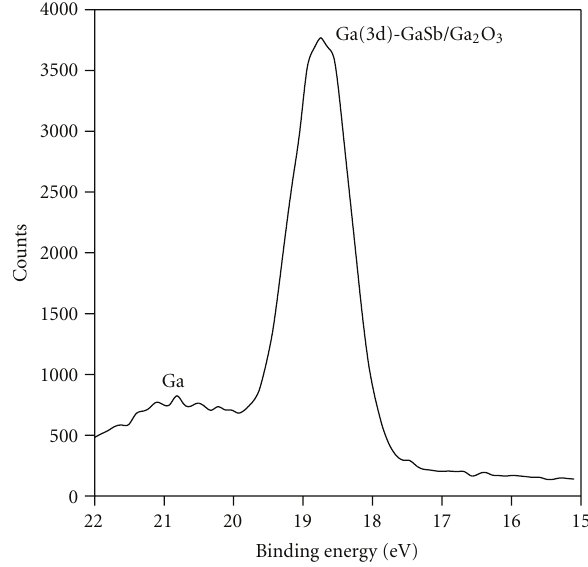
Figure 7: XPS narrow scan of Ga3d at the as-received surface of Al 0 . 05 Ga 0 . 95 Sb grown at 600 ◦ C with a V/III ratio of 3.